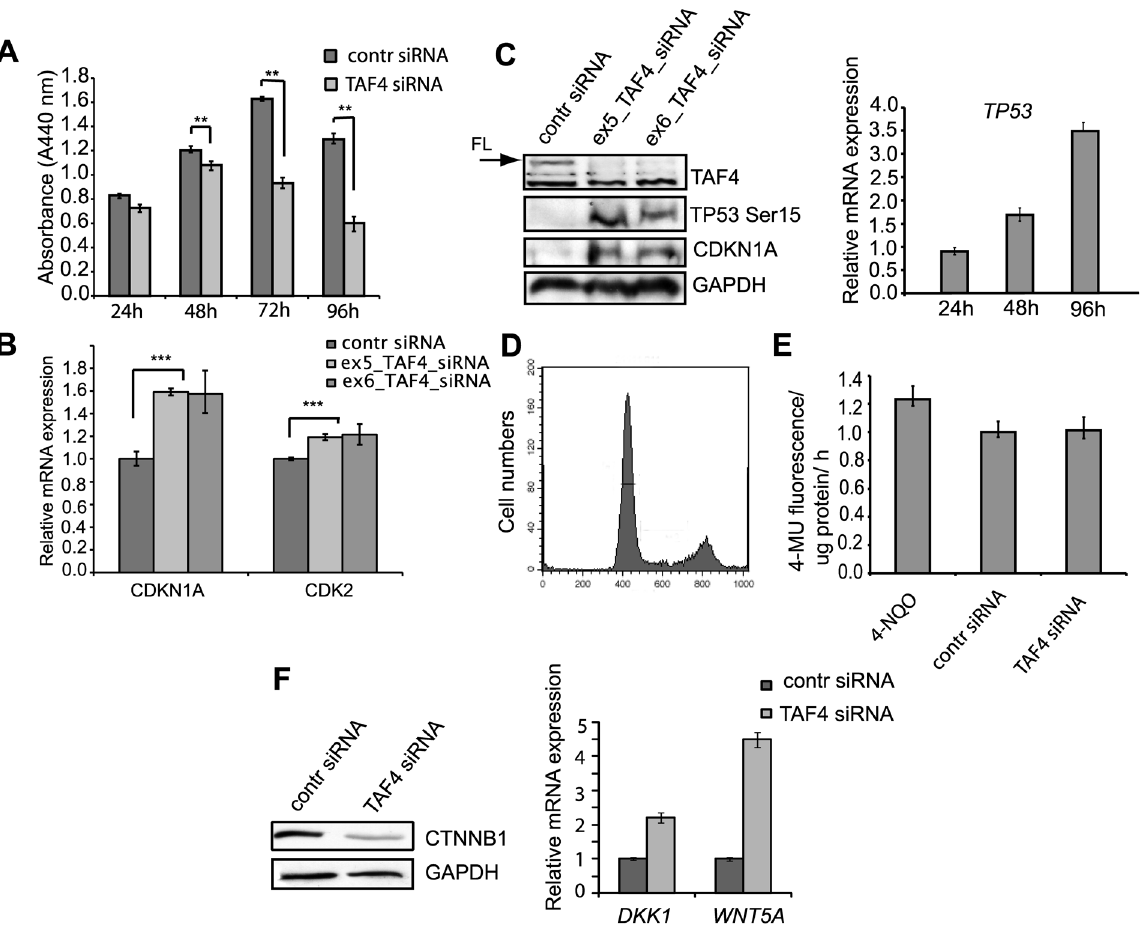
Figure 3. TAF4 siRNA treatment of human MSCs induces TP53-dependent cell-cycle arrest and switching from canonical to non- canonical WNT signaling. ( A ) Effects of TAF4 siRNA treatments on hMSC proliferation at different time points as compared to negative control siRNA. hMSCs were transfected with 50 nM of TAF4 or control siRNAs and analyzed at the indicated time points by WST-1 proliferation assay. Experiments were done in triplicate and a comparison was made to control siRNA treatments ( ** indicates significant differences between control and TAF4 siRNA groups with P , 0.01). ( B ) Down-regulation of the canonical form of TAF4 affects the expression of cell cycle regulators. hMSCs were transfected with 50 nM TAF4- specific (ex5_ or ex6_ TAF4 siRNAs) or control siRNAs. Relative expression of cell cycle regulators CDKN1A and CDK2 as compared to control siRNAs transfected cells was analyzed using real-time RT-PCR at 6 h post-treatment. Observed differences were statistically significant (Student’s t -test) with *** P , 0.001. ( C ) TAF4 siRNA-mediated RNAi affects expression of cell cycle regulator proteins. Western blot analysis of cell cycle regulators TP53 and CDKN1A/P21 24 h following transfection of hMSCs with control or both, ex5_ and ex6_ TAF4 -specific siRNAs. Expression of TAF4 and GAPDH was analyzed to ensure effective silencing and equal loading (left) . Time-dependent expression of TP53 was analyzed by real-time PCR and compared to the mRNA levels in TAF4 and control siRNA treated hMSCs (right) . ( D ) Down-regulation of the canonical form of TAF4 does not induce apoptosis. FACS analysis of the cell cycle progression of hMSCs treated with TAF4 siRNAs. ( E ) TAF4 siRNA treatment doesn’t cause senescence of hMSCs. Quantitative SA-ß-gal assay. hMSC extracts were prepared from TAF4 and control siRNA transfected cells 48 h post- treatment. 1 m M 4-NQO was added to hMSCs for 1 h and used as positive senescence control. Fluorescence intensity of 4-MU hydrolysis was normalized to total protein. Error bars in experiments represent the standard deviations of three independent experiments (P , 0.005) ( F ) RNAi of hTAF4-TAFH switches from canonical to non-canonical WNT signaling. 20 m g of control or TAF4 siRNA-treated whole cell lysates were analyzed by Western blot analysis for the expression of ß-catenin (CTNNB1) and GAPDH as loading control (left) . Real-time PCR shows increased expression of non- canonical markers of WNT signaling in TAF4 siRNA treated hMSCs as compared to control siRNA treated cells. Differences are statistically significant with P , 0.001 (right) .